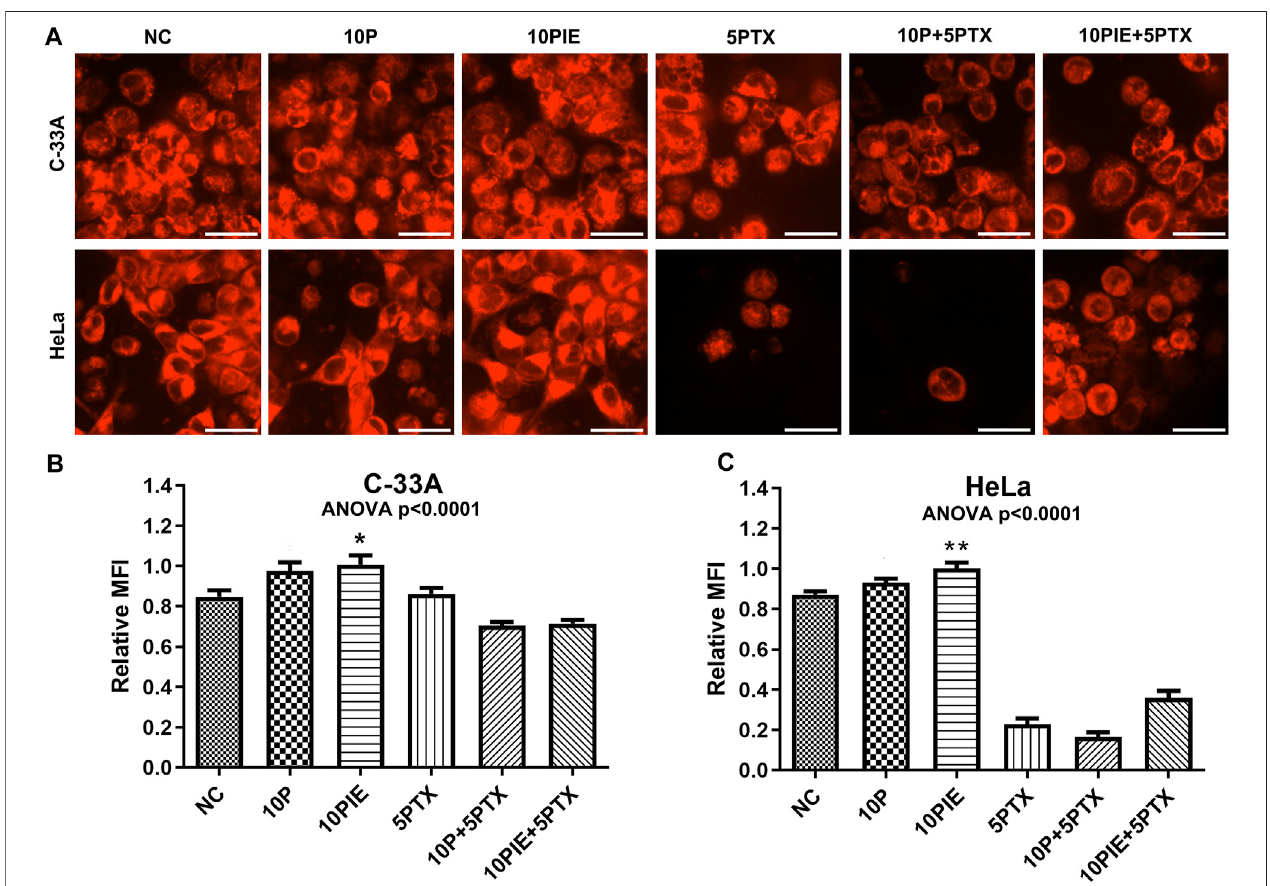
FIGURE 5 | PIE increased intracellular relative MFI of ferrous ions in C-33A and HeLa cells. (A) Intracellular ferrous ions were detected via laser scanning confocal microscopy. All the bars indicated 20 µm. (B,C) Statistical analysis of intracellular MFI in C-33A and HeLa cells under different drug treatments. * p < 0.05, ** p < 0.01.